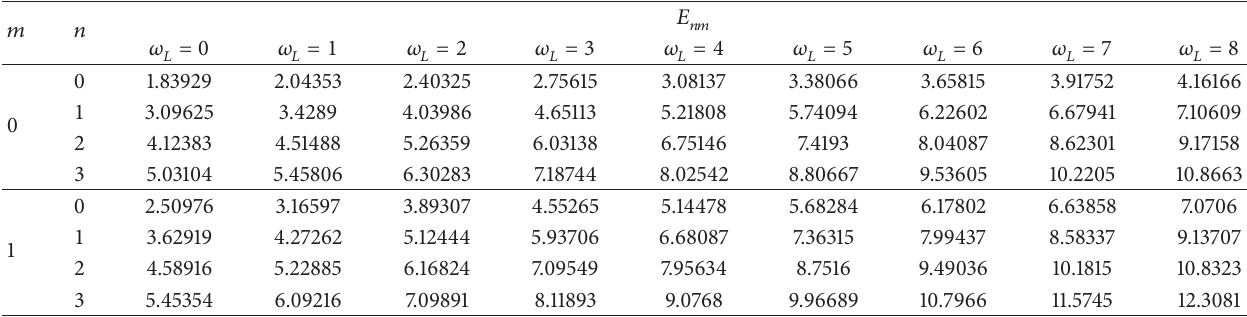
Table 1: The KG energy eigenvalues ( 𝐸 𝑛𝑚 in atomic units) of the harmonic oscillator potential for various 𝜔 𝐿 values and 𝜉 = 0 . Here, ℎ = 𝑐 = = 𝑘 = 1 . 𝑚 𝑒